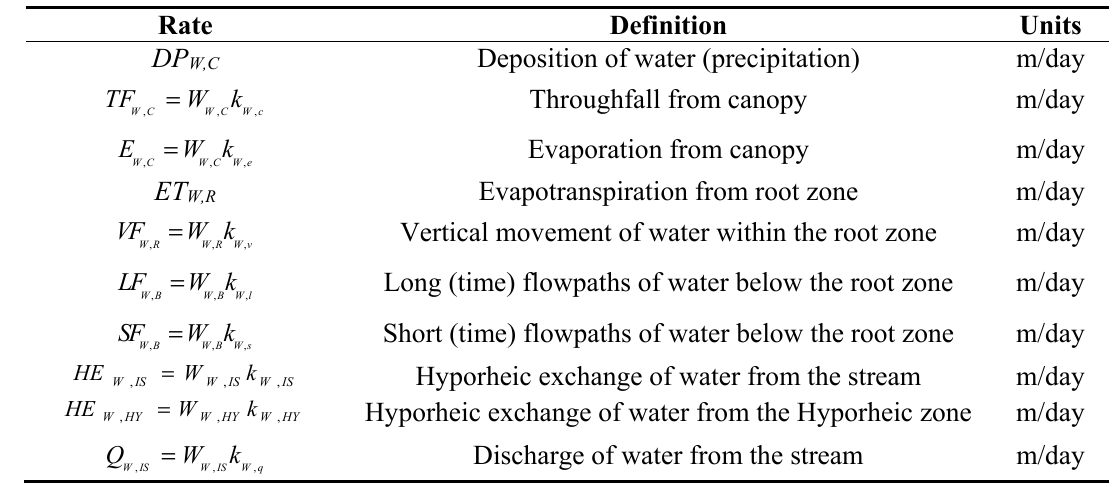
Table 3. Rate terms comprising the hydrological model. See Table 7 for parameter